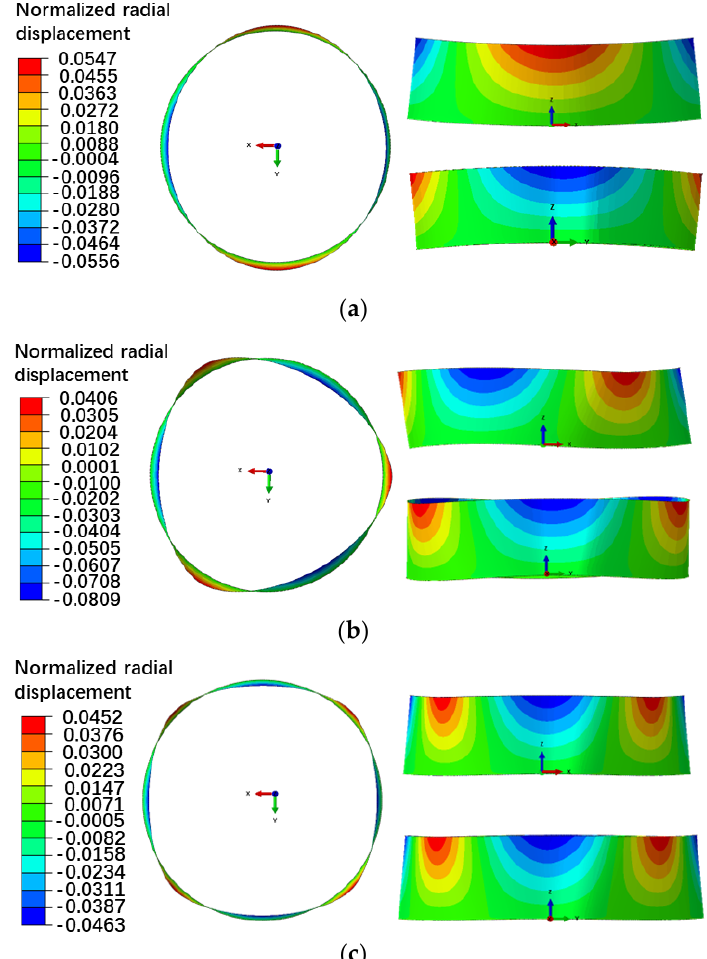
Figure 14. Deformed tank shell under wind pressure with harmonic-settlement-induced geometric imperfection: ( a ) n = 2; ( b ) n = 3; ( c ) n = 4.